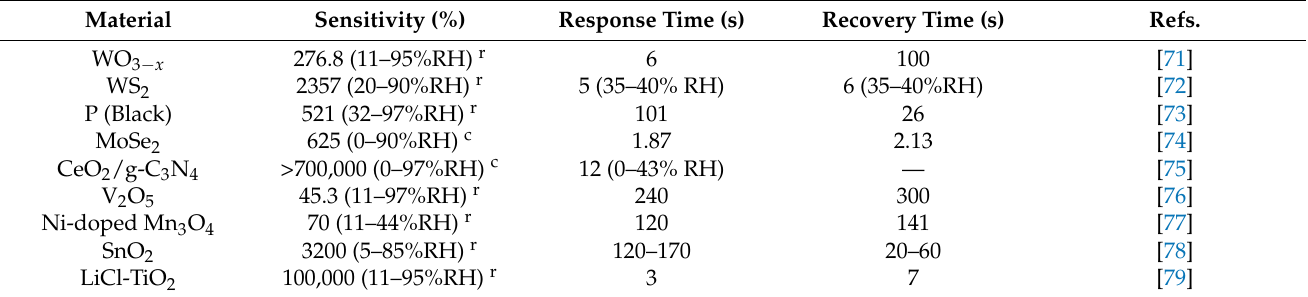
Table 2. The sensitivity, response time, and recovery time for inorganic humidity sensor